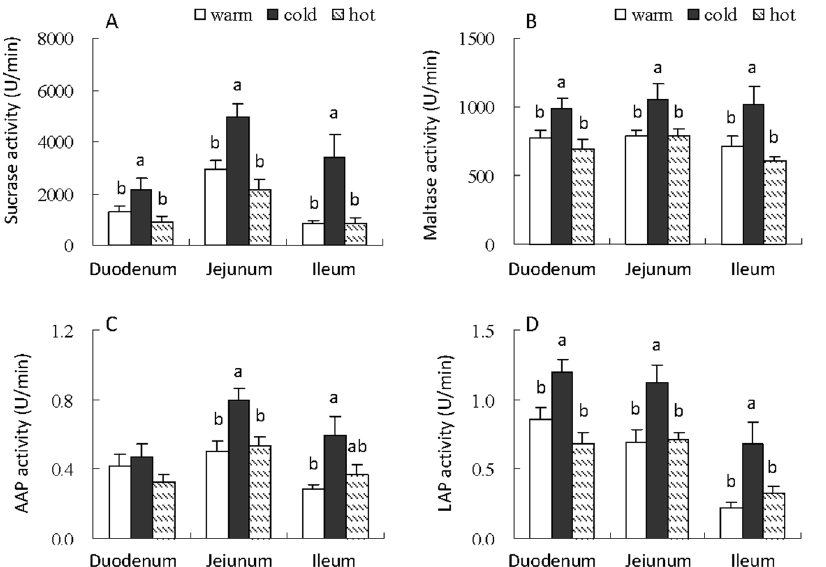
Figure 2. Activity of sucrase (A), maltase (B), AAP (C) and LAP (D) of duodenum, jejunum and ileum in striped hamsters acclimated to warm (23 6 C), cold (5 6 C) and hot (31 6 C) conditions. Different letters (a or b) above the columns indicate significant difference between the three groups ( P , 0.05). Data are means 6 s.e.m.